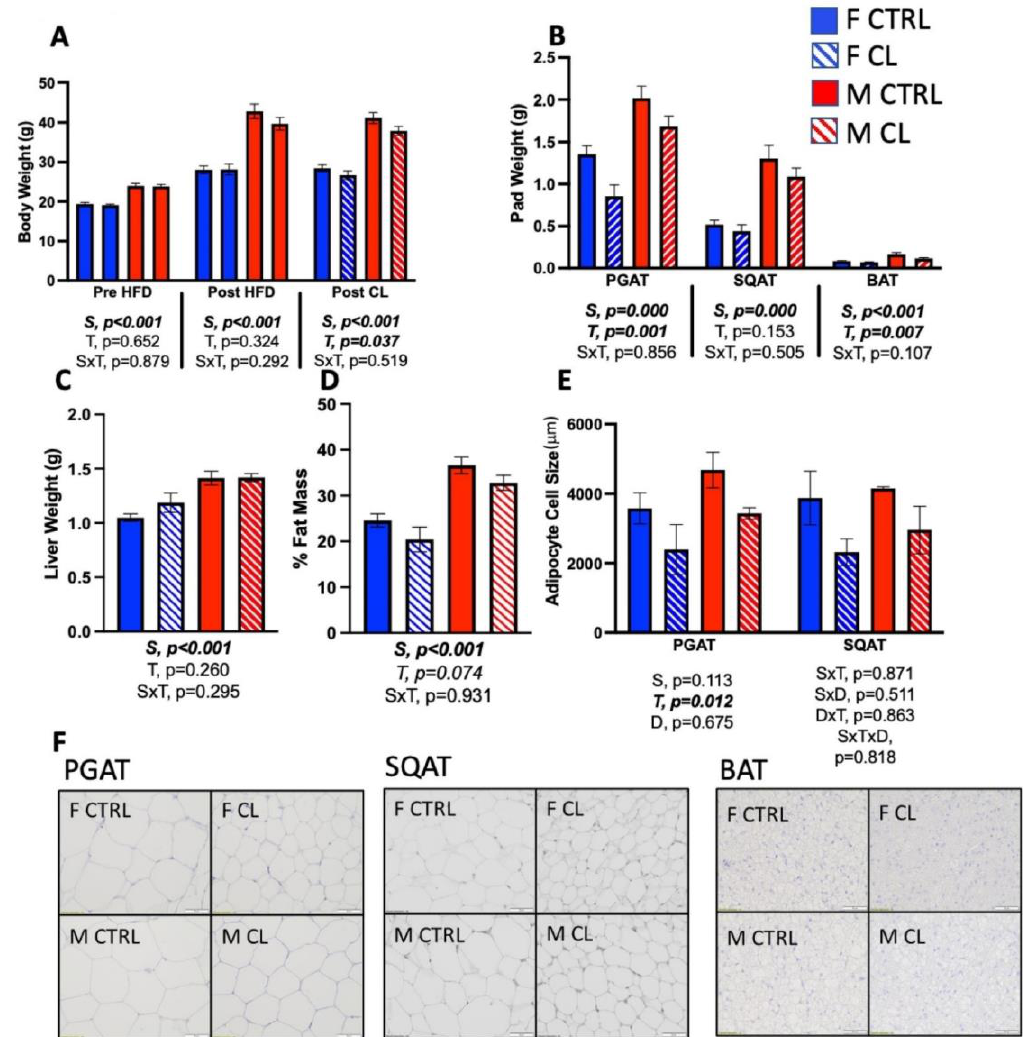
Figure 2. Male (M) and female (F) C57BL/6J mice, all on HFD, were given daily CL injections (1 μg/g body weight) or CTRL (saline) for 14 days, and body composition was assessed. ( A ) Average body weight at the start of the study (i.e., before HFD), post-HFD (i.e., after 14 weeks HFD feeding, before 2-week CL treatment) and post-CL (i.e., after 14 weeks HFD feeding, following 2-week CL treatment). ( B ) Pad weight for perigonadal (PGAT), subcutaneous (SQAT) and brown (BAT) adipose tissue; ( C ) liver weight; ( D ) % fat mass; ( E ) PGAT and SQAT average adipocyte size; ( F ) PGAT histological images; SQAT histological images; BAT histological images. All data are presented as mean ± SEM. N = 3/group for his- tology; N = 10–15/group for all other outcomes. Main effects of sex (S) and CL treatment (T) and sex by treatment interac- tions (S×T) were determined by 2 × 2 ANOVA and are presented below the respective figures. For adipocyte size compar- isons across WAT depots (D), the main and interaction effects of depot (D), S, and T were assessed using 3 × 2 ANOVA. A p -value < 0.05 was accepted as significant.